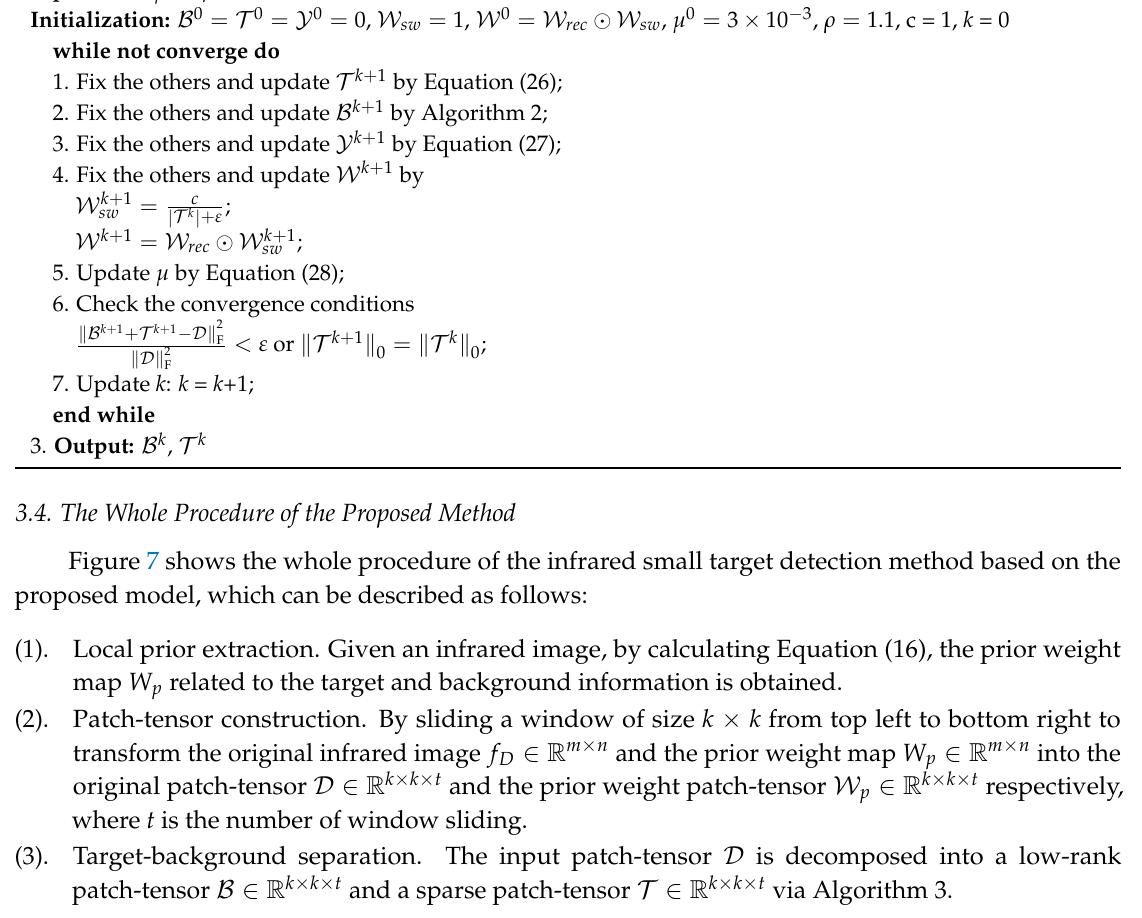
Algorithm 3 ADMM solver to the proposed